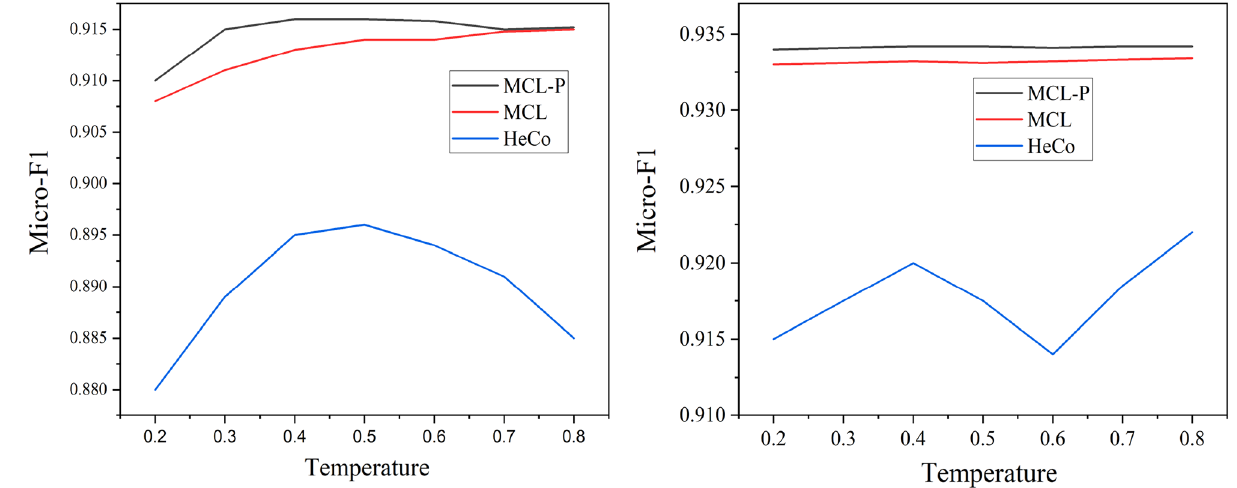
Figure 7. Hyperparameter sensitivity of temperature τ terms of Micro-F1.